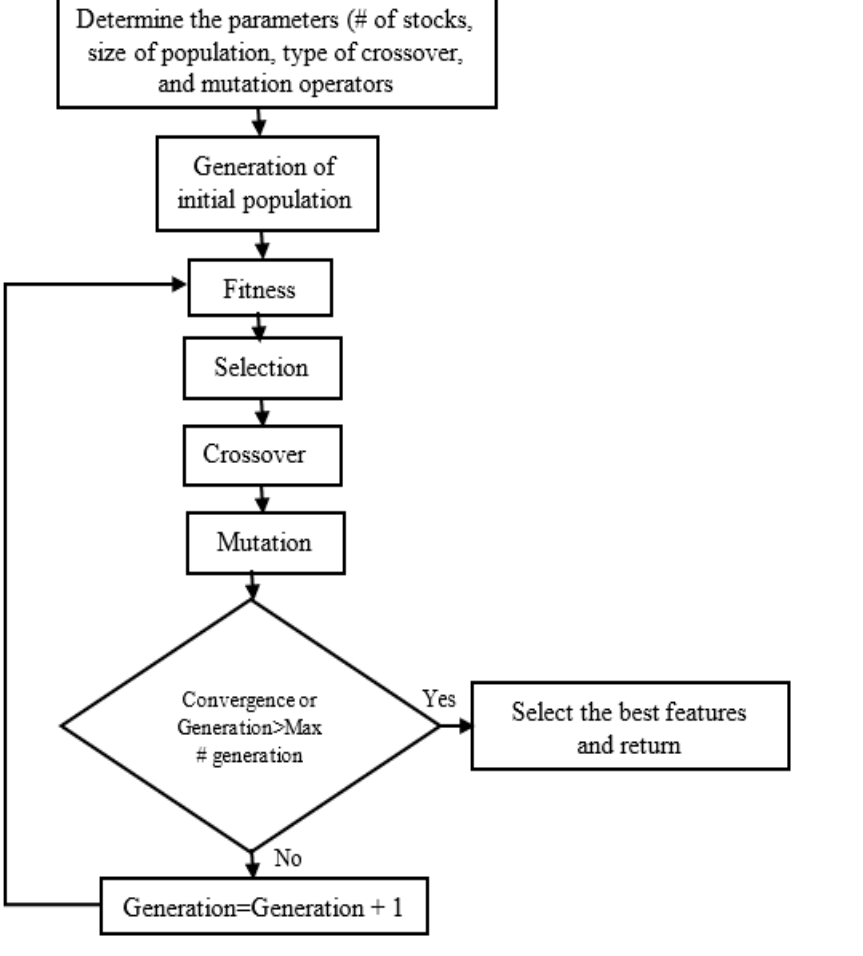
Figure 5. A flow chart of a genetic algorithm optimization.